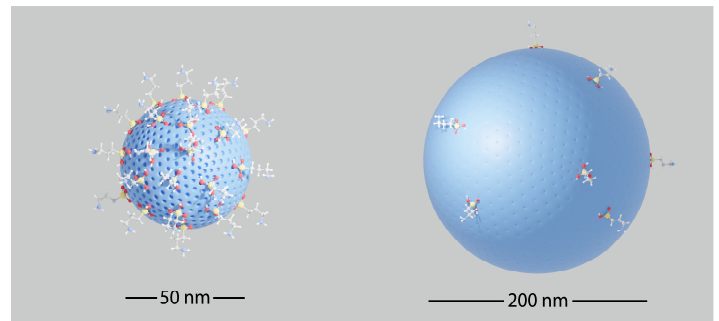
Figure 1. Representation of the two silica-based nanoparticles coated with APTES.